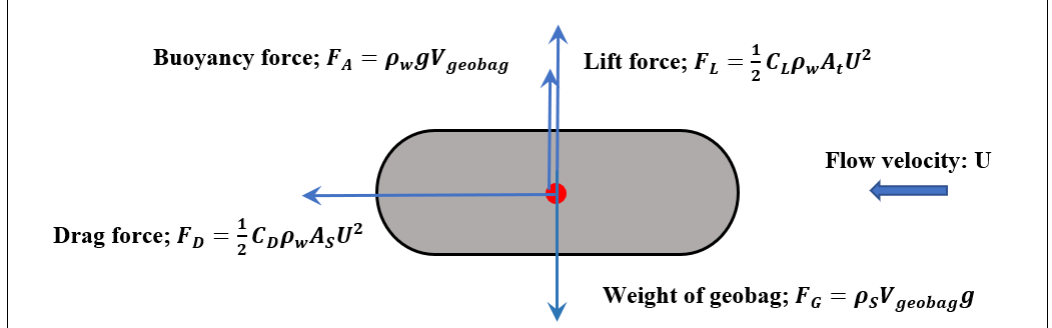
Figure 1. Forces acting on a submerged geobag.